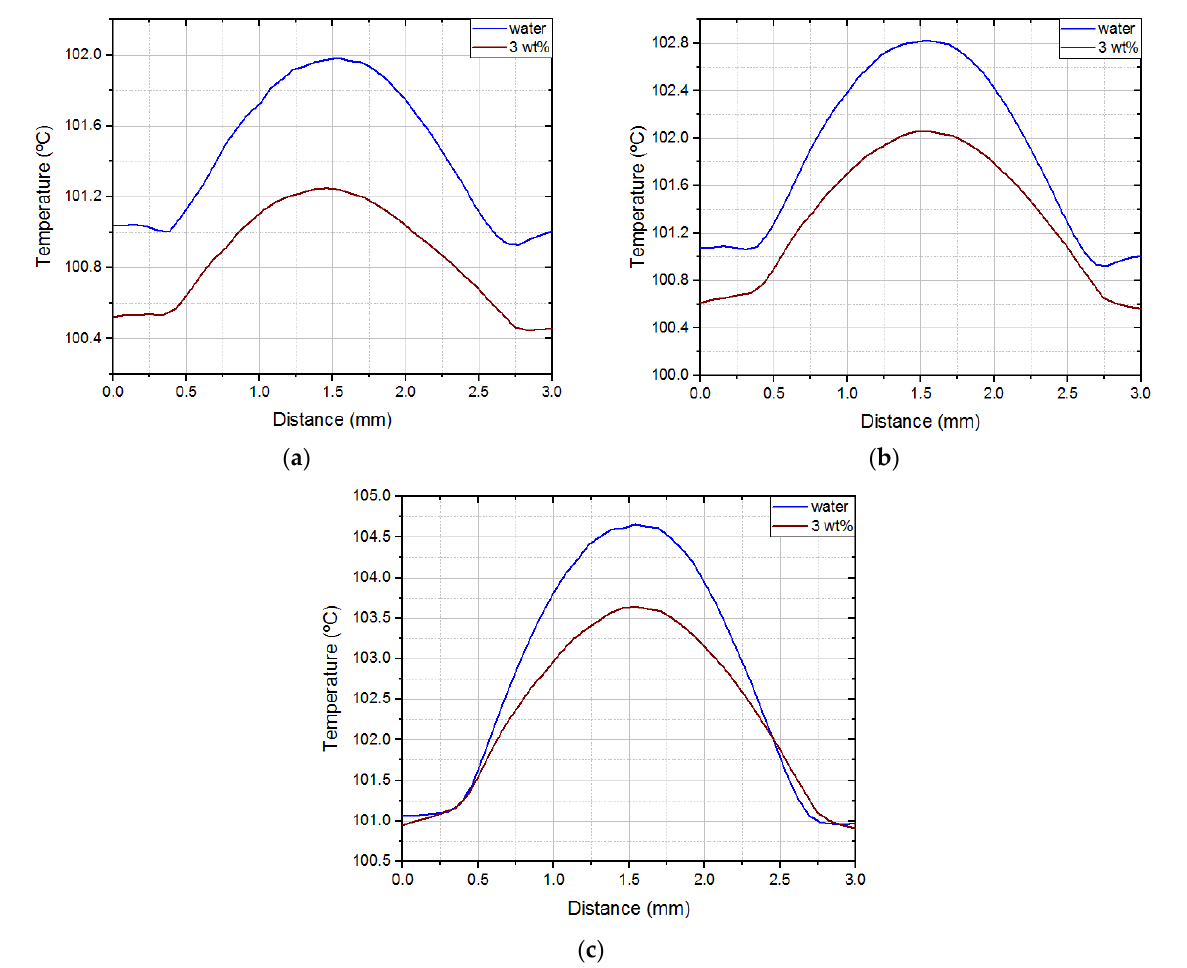
Figure 9. Mean surface temperature profiles. Septuple superhydrophobic region with 1.5 mm diameter spots. The imposed heat fluxes are: ( a ) 1290 W/m 2 (7 A), ( b ) 2132 W/m 2 (9 A), and ( c ) 3790 W/m 2 (12 A).